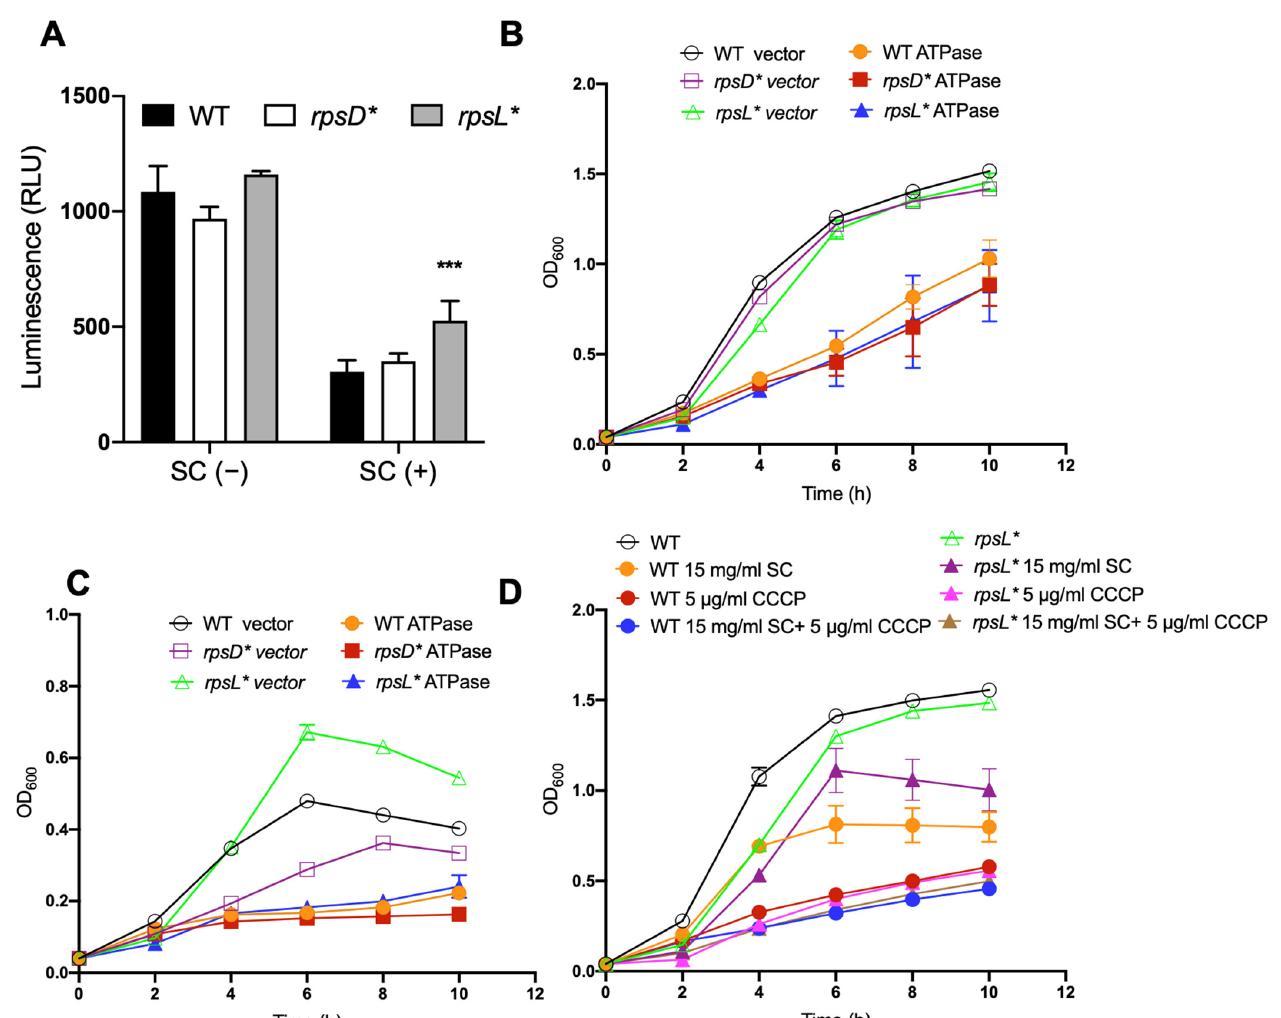
Figure 4. Improved fitness in error-restrictive strain depends on increased ATP levels. ( A ) Determi- nation of intracellular ATP levels. Overnight cultures were diluted 1:100 in fresh LB with or without 20 mg/mL sodium cholate and incubated at 37 ◦ C with agitation for 6 h. The cellular ATP level (indicated by the luminescence signal) decreased significantly in all three strains after exposure to bile salts, and the rpsL * strain maintained the highest level of ATP. ( B , C ) Growth curve of Salmonella strains harboring plasmid of IPTG-inducible ATPase. Overnight cultures were diluted 1:100 in fresh LB supplemented without ( B ) or with ( C ) sodium cholate and incubated at 37 ◦ C for 10 h with shaking. In total, 1 mM IPTG was added to induce the expression of ATPase for ATP hydrolysis. ( D ) Growth curve of Salmonella strains with and without CCCP to inhibit ATP synthesis. The data are representative of results from at least three biological replicates. The p -values were determined using the independent t -test. ***, p <